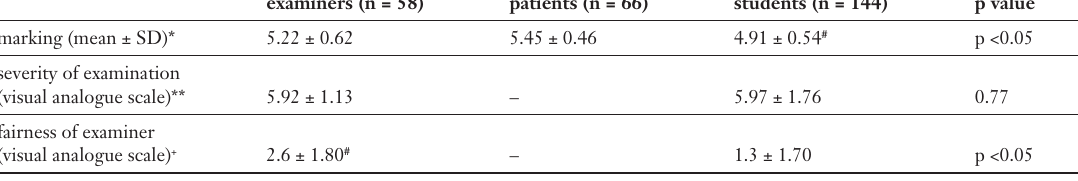
Marking of students, estimation of exami- nation’s severity and rating of fairness of